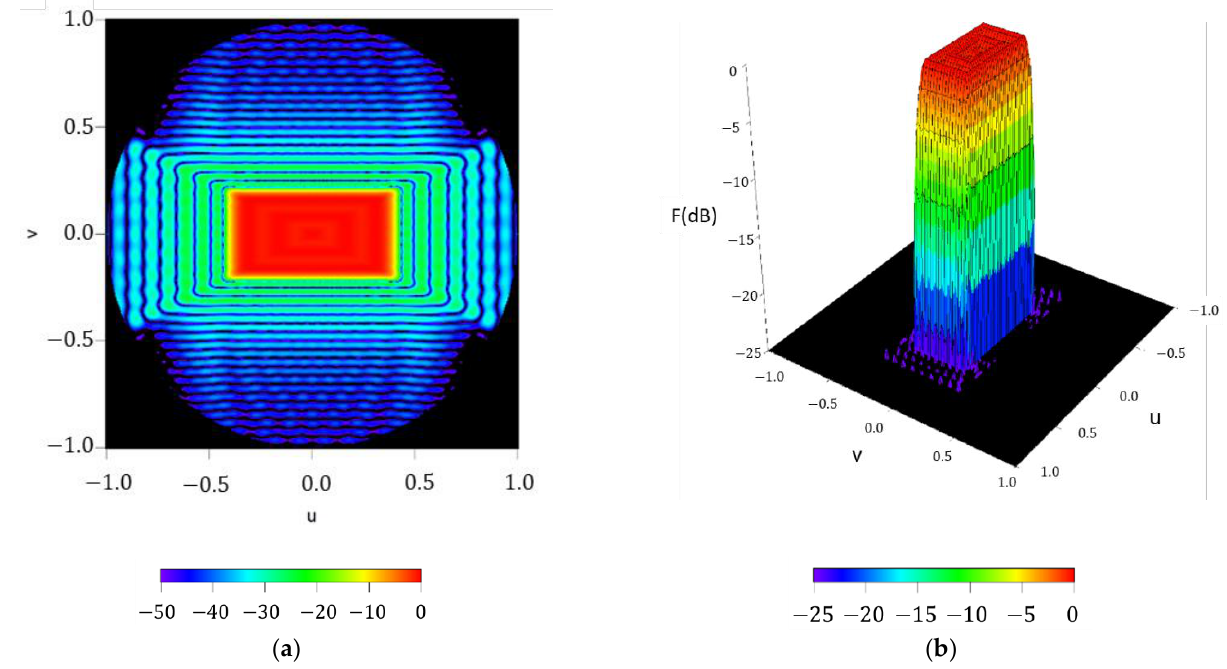
Figure 9. Reconstructed pattern of the required footprint for the case of a rectangular boundary of 20 ◦ × 40 ◦ by means of the obtained Fourier coefficients in (2): ( a ) interpolated image with a threshold of − 50 dB ( b ) surface plot with a threshold level of − 25